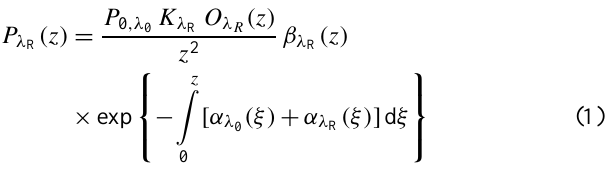
Figure 1. Map of the area around Jülich with westward (blue) and eastward (red) RS trajectories. The darker area in the east indicates the open-cast mining and the brighter area in the north indicates a hill named